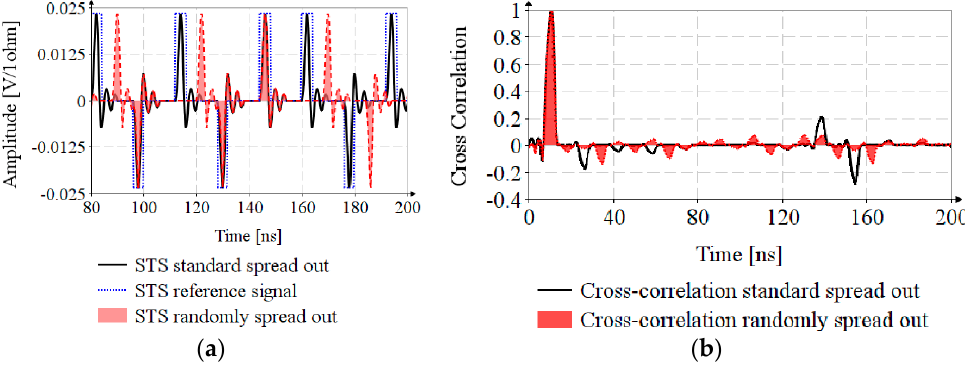
Figure 4. Timestamp estimation by STS: ( a ) UWB pulse position in STS sequence; ( b ) cross-correlation of STS sequences with reference signal.